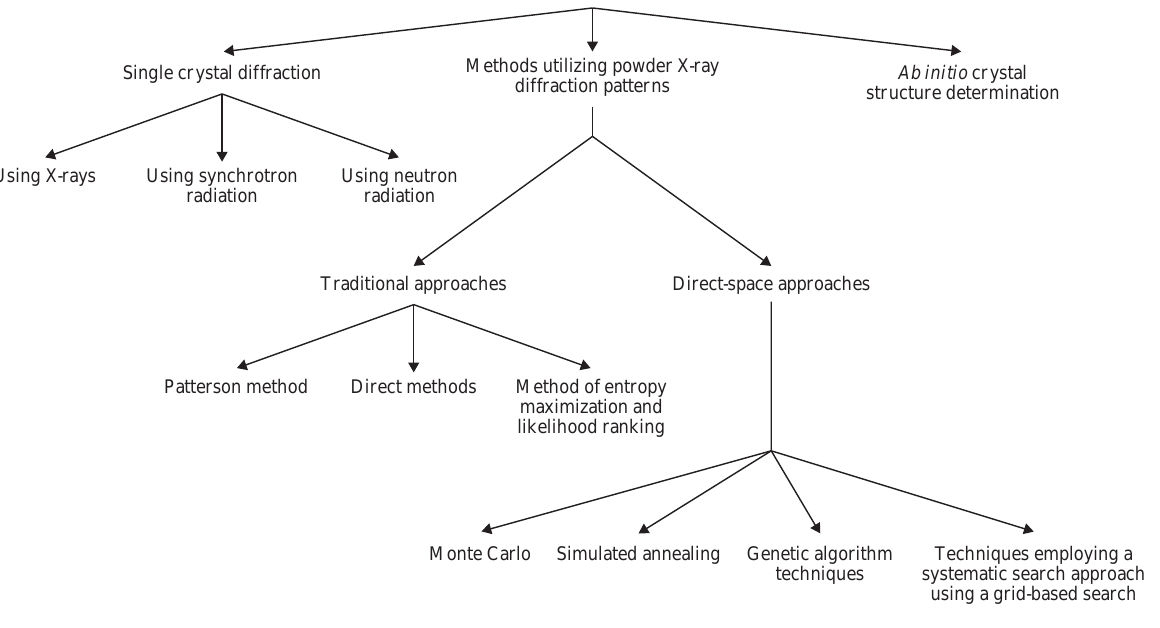
( Table 2 ): (1) methods utilizing single crystals, (2) methods utilizing powder X-ray diffraction patterns, and (3) methods that determine crystal structure from molecular structure alone, i.e., ab initio methods. Each of these methods may be further subclassified, as in Table 2 . The salient features of the three meth- ods are outlined below.